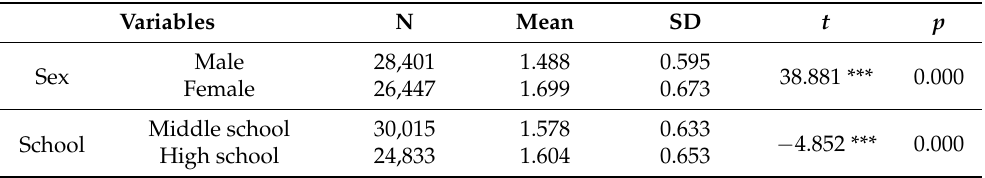
Table 3. Comparison of mean GAD scores by sex and